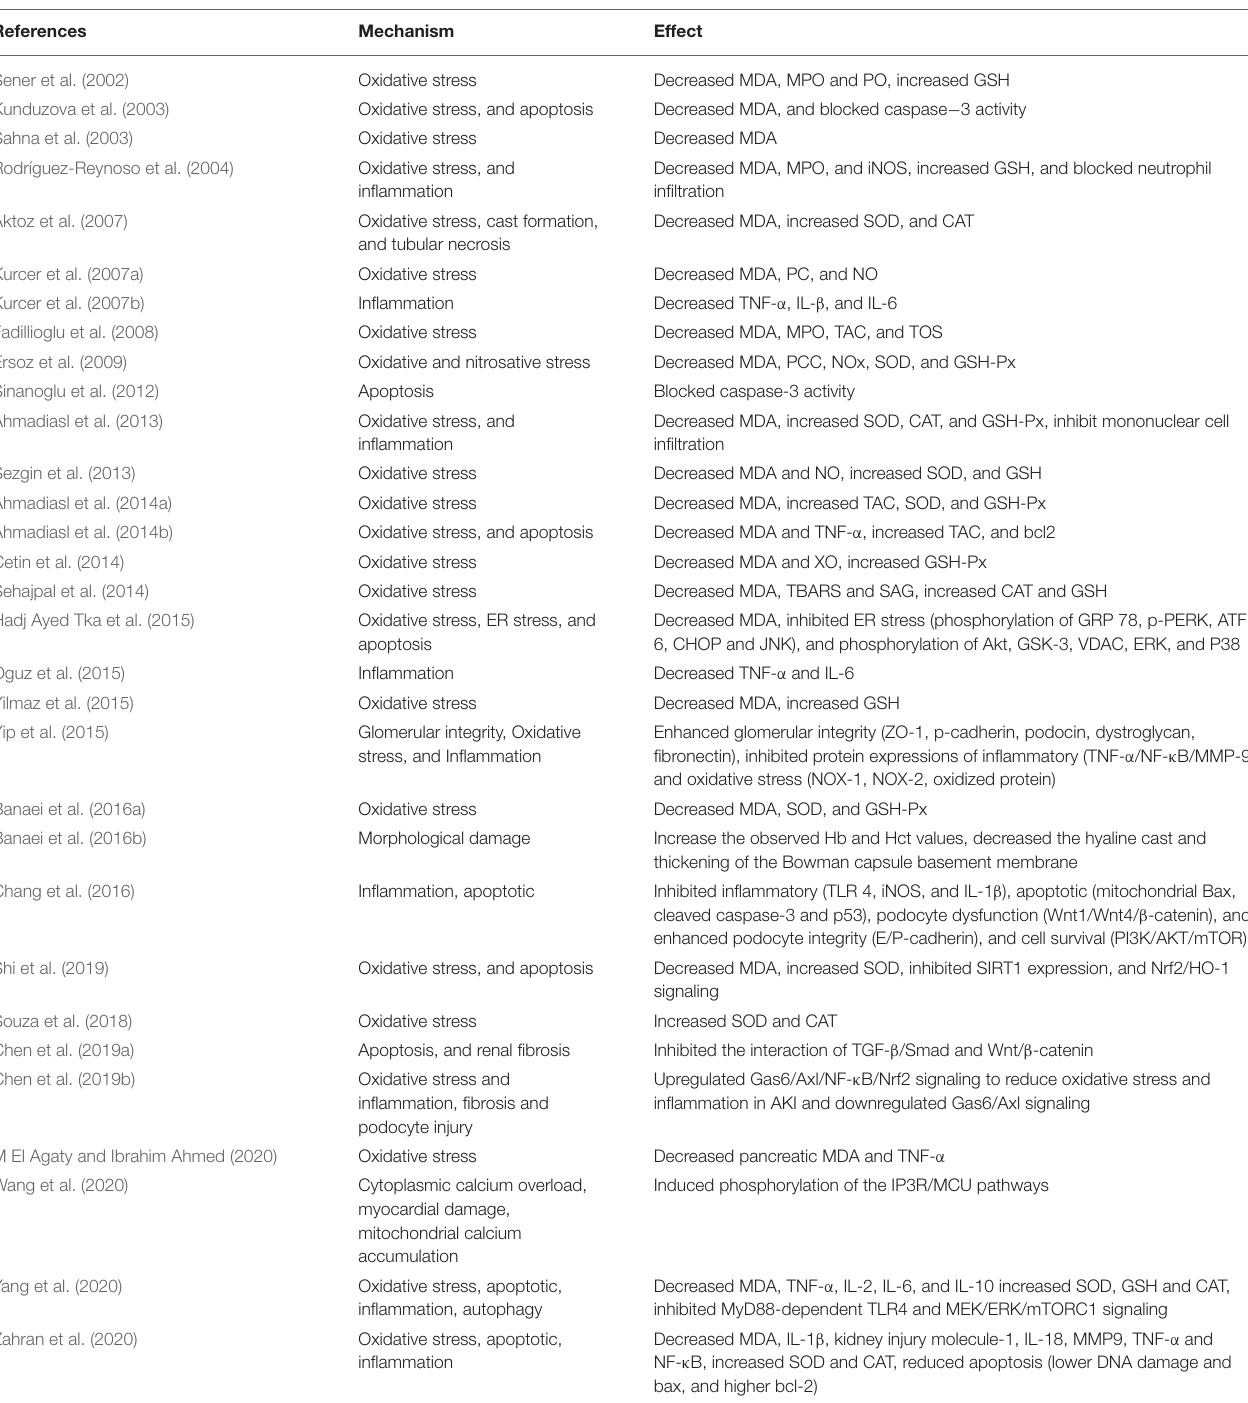
TABLE 5 | The proposed molecular and cellular mechanism of the protective effect of melatonin for renal I/R